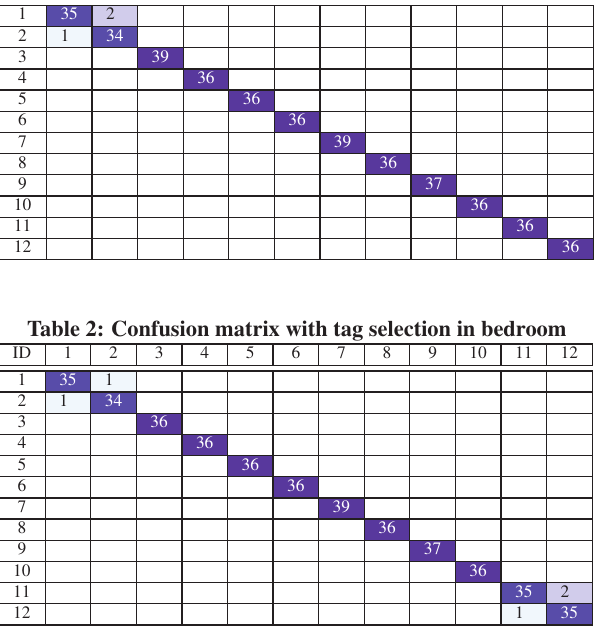
Table 1: Confusion matrix with tag selection in lab ID